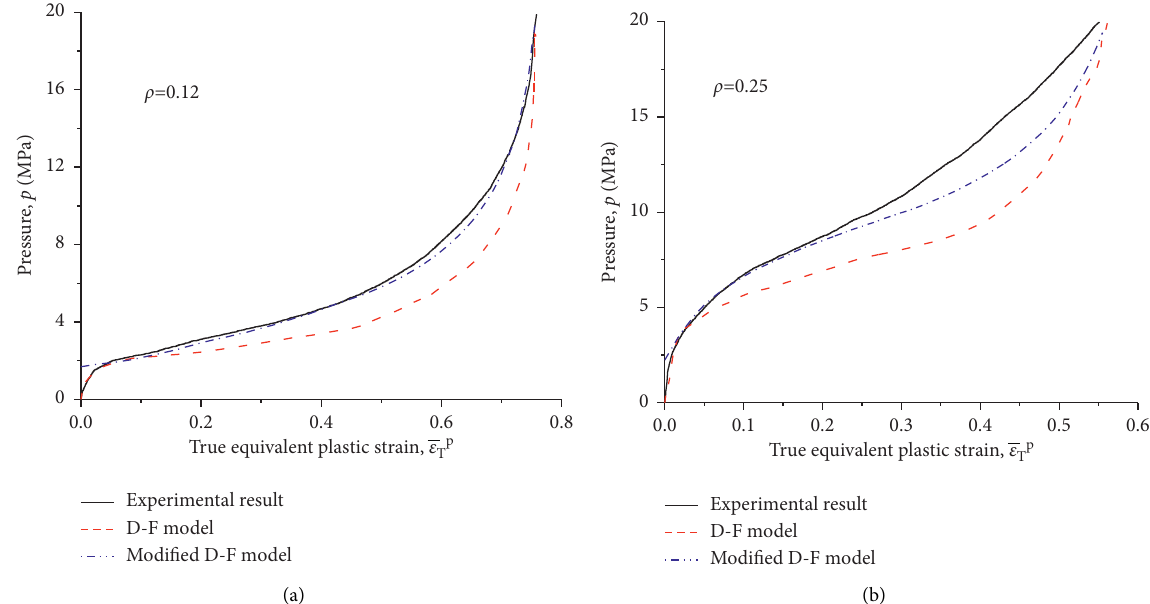
Figure 19: Predictions of pressure under hydrostatic compression according to the D-F model and modified D-F model: (a) ρ � 0 . 12 and (b) ρ � 0 . 25.